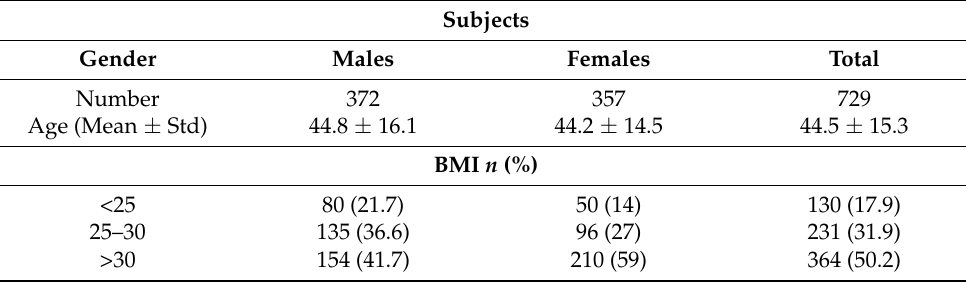
Table 1. Clinical and epidemiological features of the study population ( n =